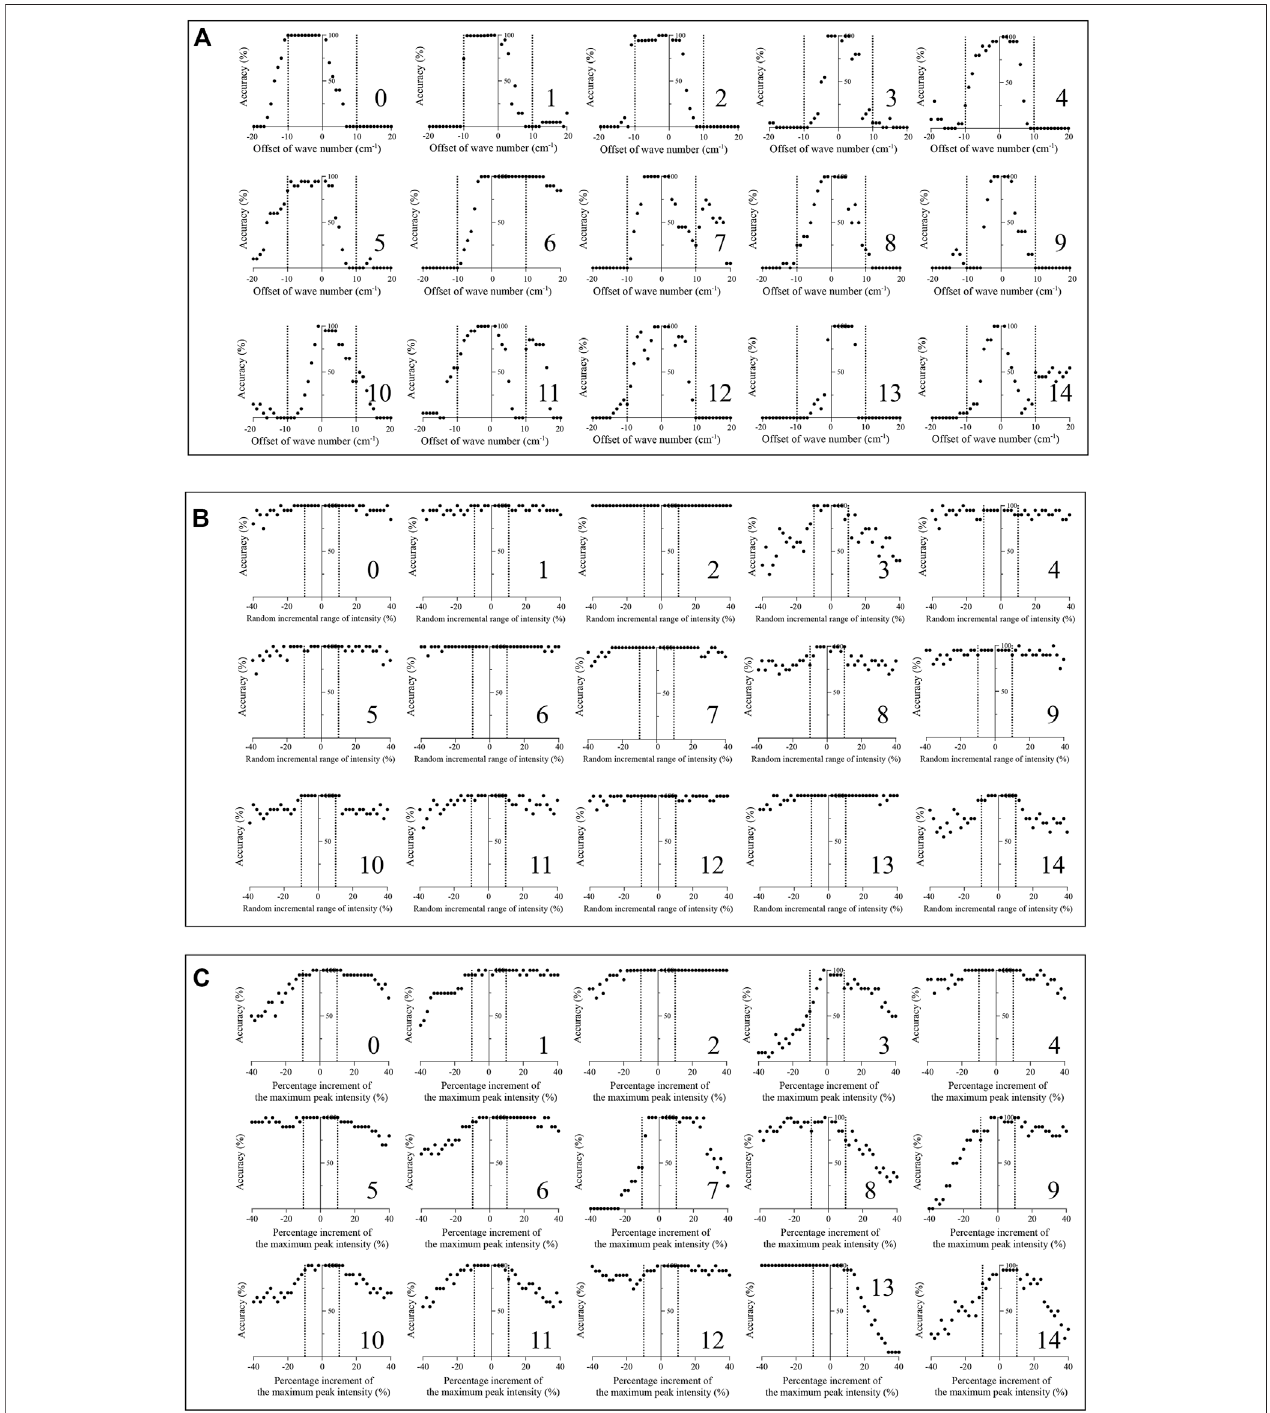
FIGURE5| Robustnesstestofthepresentalgorithmon15therapeuticmAbs. (A) Theclassi fi cationeffectofthepresentalgorithmagainstsimulatedspectralpeak drift ( n = 20); (B) The classi fi cation effect of the present algorithm against simulated spectral noise ( n = 20); (C) The classi fi cation effect of the presented method against simulated spectral fl orescence interference ( n = Figure 5C , all simulated spectra with a 10% or − 10% 95%. The simulated spectra of therapeutic mAbs labelled two could be correctly identi fi ed, while the random incremental increment of the maximum peak intensity could be identi fi ed range of intensity was in the range of ±40%. As shown in and achieved an accuracy over 95%. The results indicated that